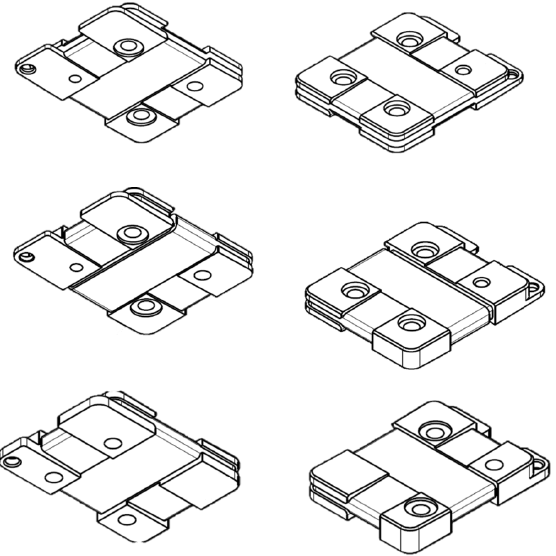
Figure 1. Three axes reel ( top ), two axes and single axes reel ( middle ), external two axes reel ( bottom ).